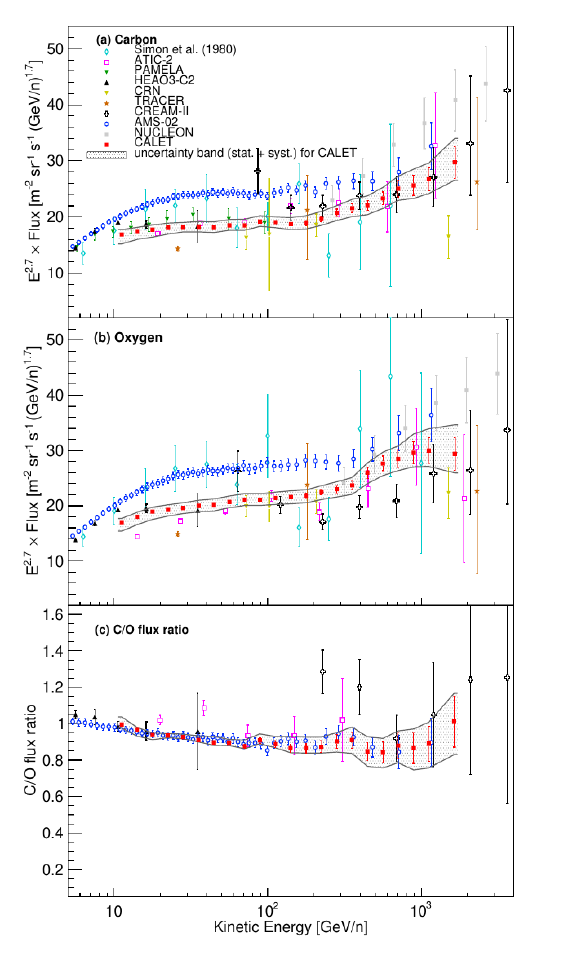
Figure 6. Carbon (top panel) Oxygen (central panel) and ratio C / O (bottom panel) measured by di ff erent experiments